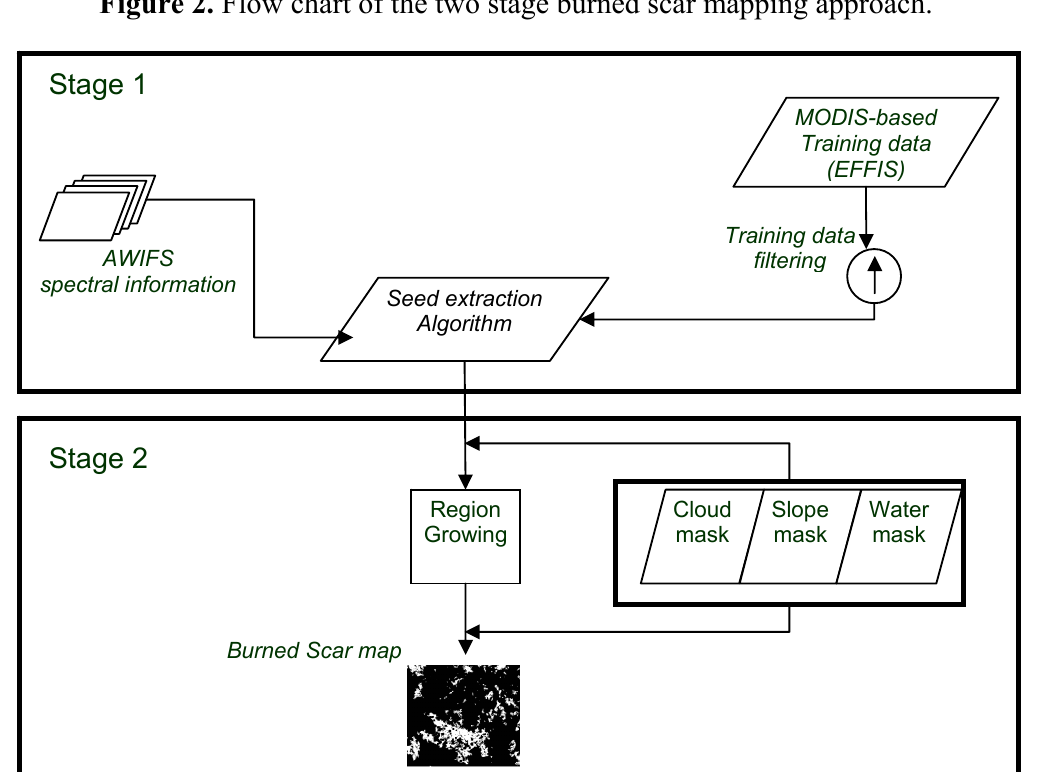
Figure 2. Flow chart of the two stage burned scar mapping